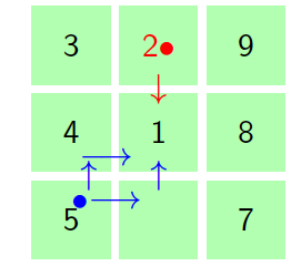
Figure 10 delineate the movement of the molecule from state j > 1 to state 1 at n = 2. When the molecule